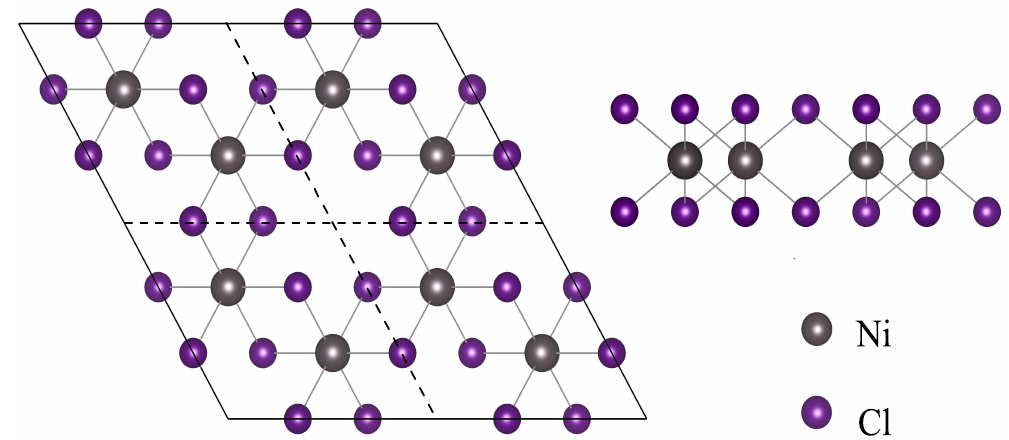
Figure 1. The top and side view of NiCl 3 monolayer, respectively.